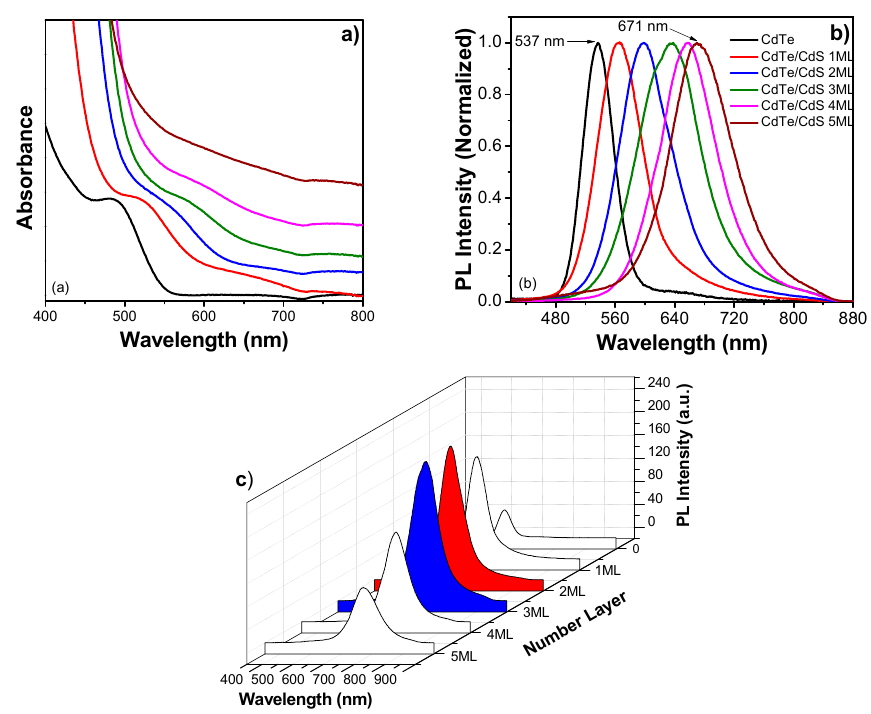
Figure 2. UV–vis absorption ( a ) and PL spectra ( b ) and ( c ) of CdTe/CdS QDs with one to five layers of CdS synthesized with CdTe core of 2.17 nm diameter.